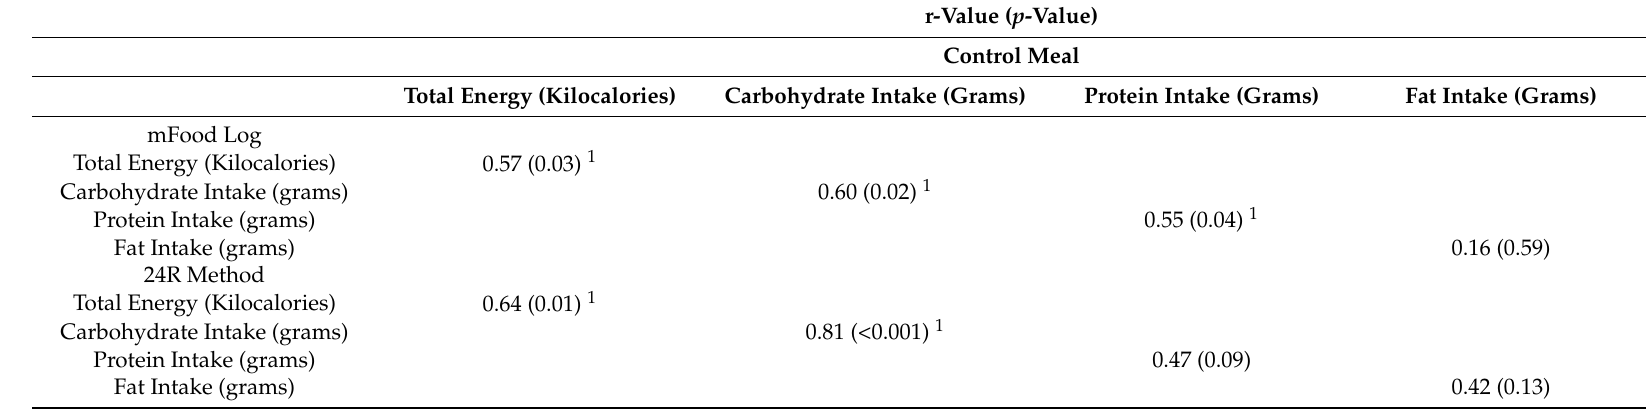
Table 3. Pearson’s correlation analyses (with reported r- and p -values) of total energy and macronutrient intake between control, mfood log, and 24R methods. r-Value ( p -Value) Control Meal Total Energy